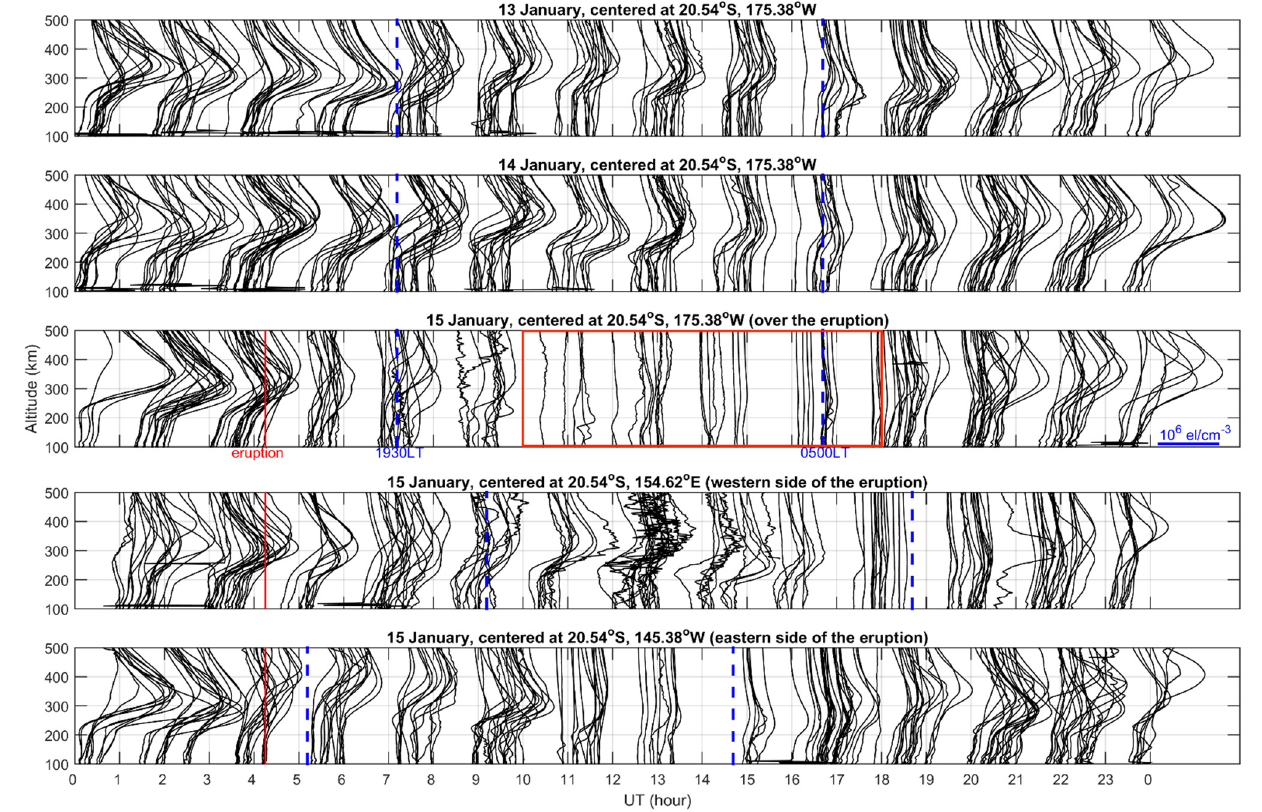
Figure 2. Top three panels: the ionospheric RO Ne profiles within the radius of 2000 km centering at 20.54 ◦ S, 175.38 ◦ W (over the eruption) on 13, 14, and 15 January. The Ne value of each profile at 100 km altitude corresponds to its universal time. The vertical red line indicates the eruption on 15 January. The vertical blue lines indicate the sunset and sunrise at ~19:30 LT and ~05:00 LT, respectively (https://www.timeanddate.com/sun/tonga/nukualofa, accessed on 17 July 2022). The red rectangle denotes the Ne profiles without the typical Chapman-layer structure mainly during the period between 10:00–18:00 UT on 15 January. Bottom two panels: the Ne profiles within the radius of 2000 km centering at 20.54 ◦ S, 154.62 ◦ E (western side of the eruption) and 20.54 ◦ S, 145.38 ◦ W (eastern side of the eruption) on 15